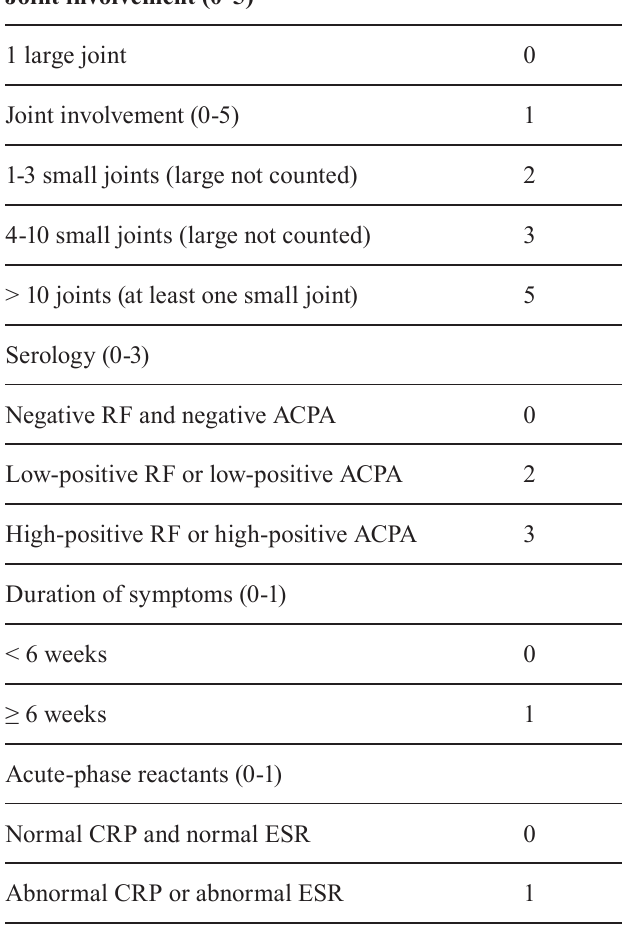
TABLE I – T he 2010 American College of Rheumatology/ European League Against Rheumatism classification criteria for